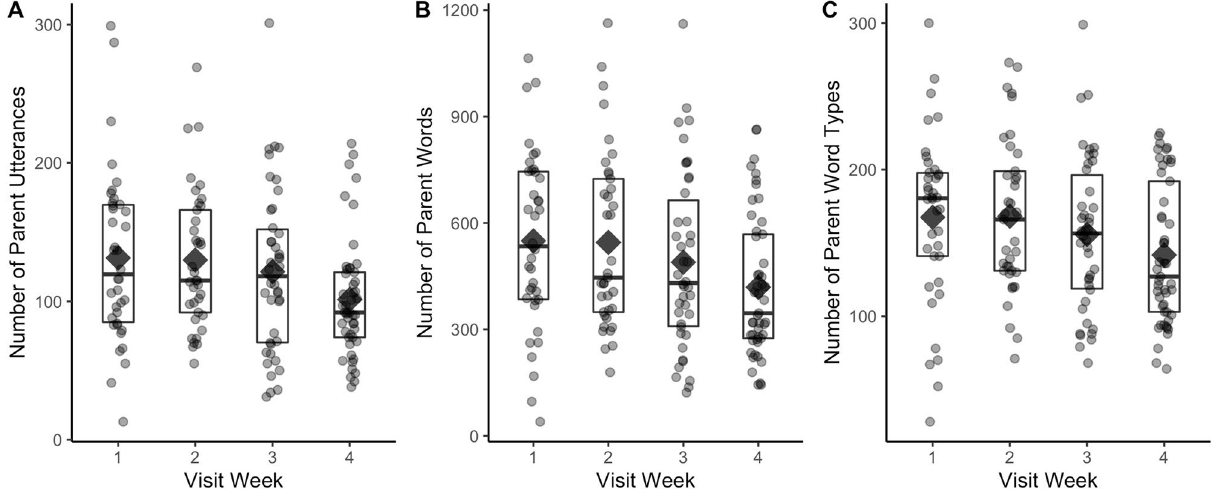
Figure 2. Number of parent utterances ( A ) word tokens ( B ) and word types ( C ), separately by visit week. Dots represent individual participants, diamonds indicate the mean, boxes represent the interquartile range, and the horizontal line in each box indicates the